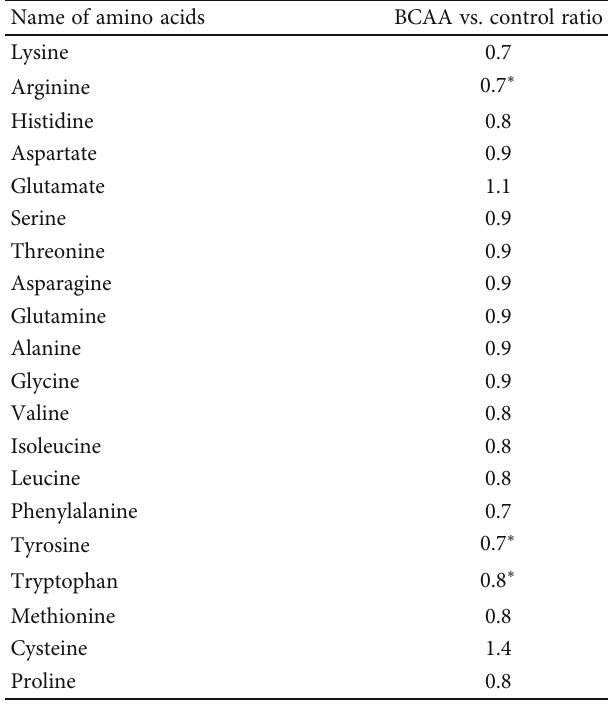
Table 1: Relative changes of intracellular amino acids in astrocytes. Name of amino acids